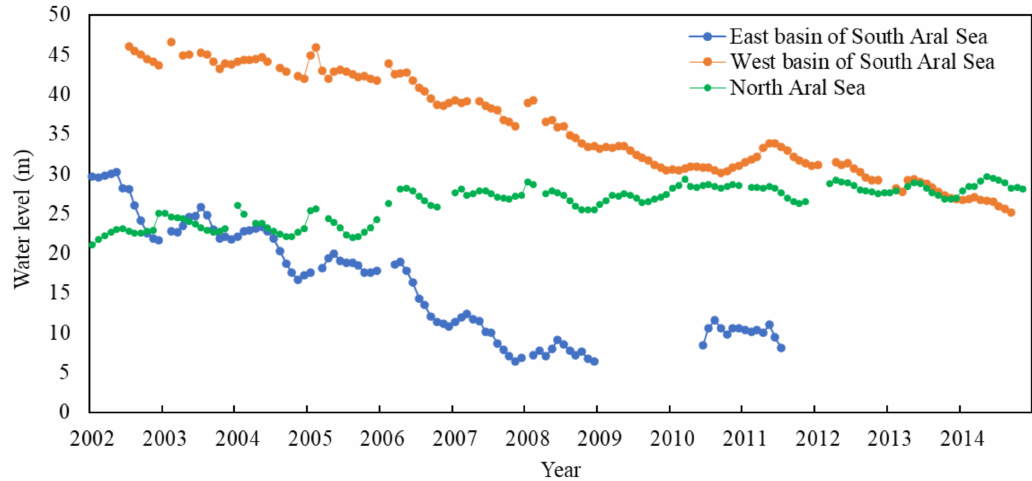
Figure 13. Water level change of the North and South Aral Seas